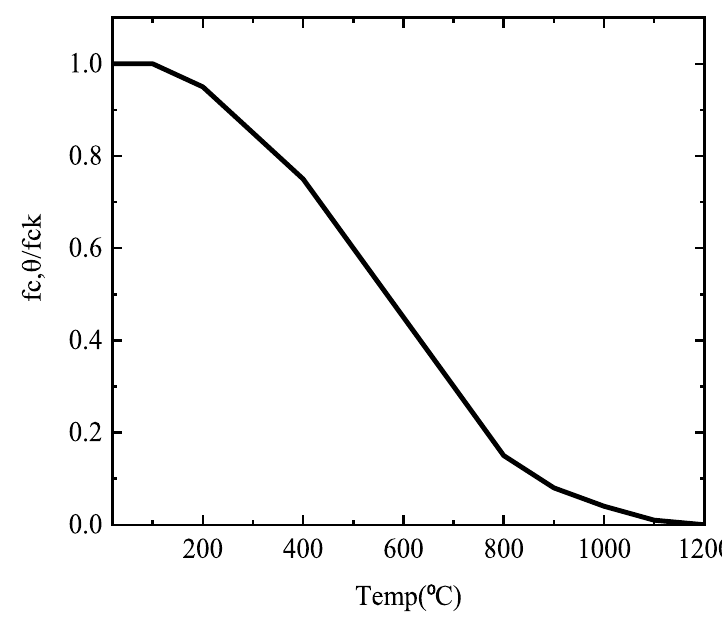
Fig. 17 Compressive strength of concrete at elevated temperatures [20]